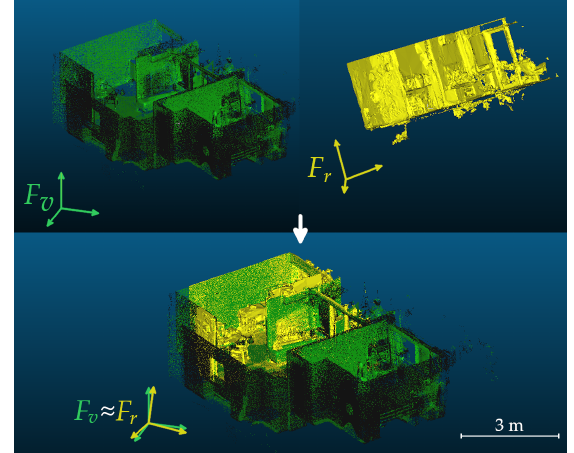
Figure 1. The registration of the real world frame (yellow) represented by the polygonal mesh model captured by the MR device (location 1 of the testing site) to the virtual world frame (green) represented by the reference point